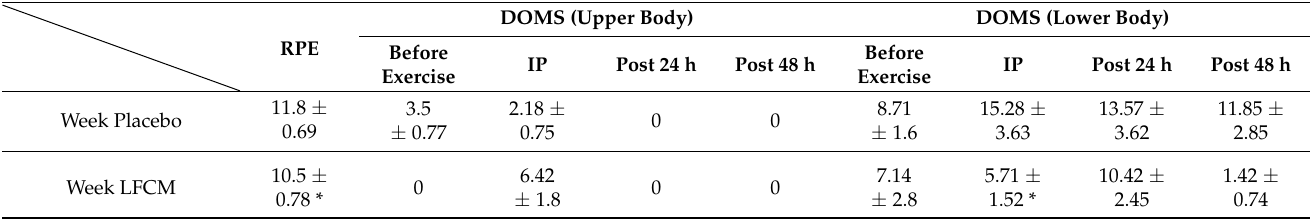
Figure 2. Subjective measurements of maximum and relative explosive power of lower extremity muscles on post-test–placebo and post-test–LFCM. Values are mean (* = Significantly different ( p < 0.05) from maximum explosive power week placebo, ** = Significantly different ( p < 0.05) from relative explosive power week placebo, † = Significantly different ( p < 0.05) from relative explosive power baseline, ‡ = Significantly different ( p < 0.05) from maximum explosive power baseline). Table 4. Subjective measurements of RPE and delayed onset soreness of upper body and lower body in the placebo and chocolate milk interventions. Values are mean ± SD ( p < 0.05) (* = Significantly different ( p < 0.05) from week